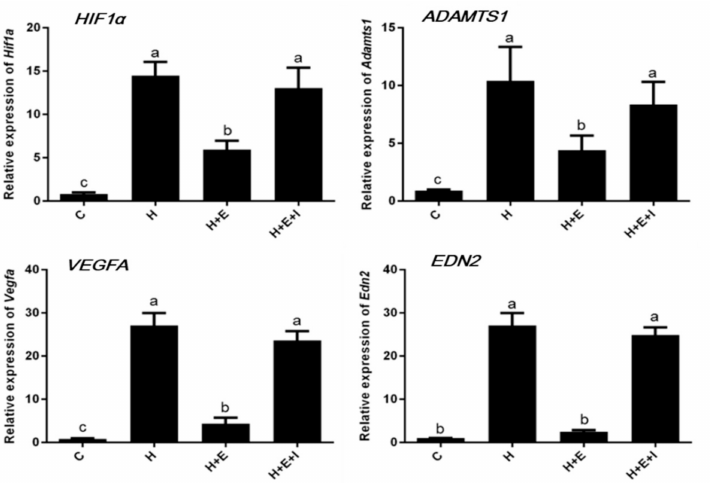
Figure 2. E ff ects of hypoxia on relative expression of HIF1A , ADAMTS1 , VEGFA , and EDN2 genes in bovine early preantral follicles. C, Control; H, Hypoxia; H + E, Hypoxia with E 2 ; and H + E + I, Hypoxia with E 2 and ICI. Di ff erent letters (a–c) on the bar means significant di ff erences ( p <